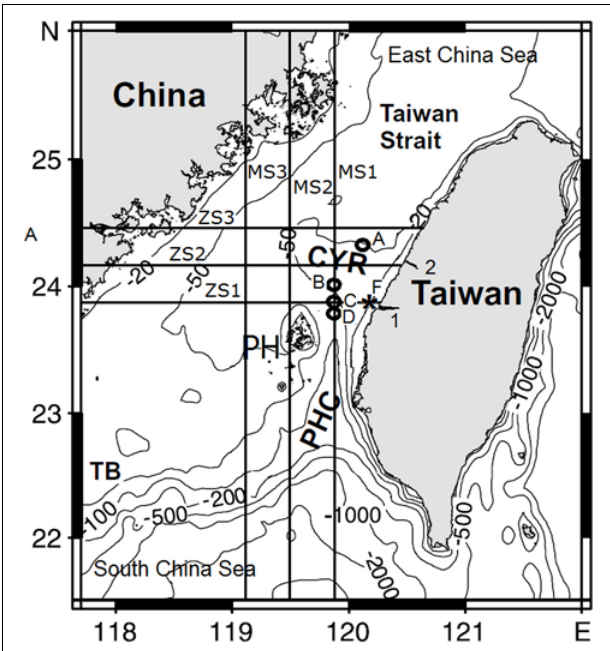
FIGURE 1 | Bathymetry of the Taiwan Strait. Solid horizontal (ZS1–3) and vertical (MS1–3) lines denote zonal and meridional exploratory sections for power density assessment. Numbers 1 and 2 denote Zhuoshui and Wu river’s estuaries. The asterisk F denotes the site of the hydrographic survey. Letters A–D indicate the sites of turbulent diffusivity estimates (see section Tidal Turbulence in the Peng-Hu Channel). CYR, Chang-Yuen Ridge; PH, Peng-Hu Archipelago; PHC, Peng-Hu Channel; and TB, Taiwan Bank (modified from Jan and Chao,